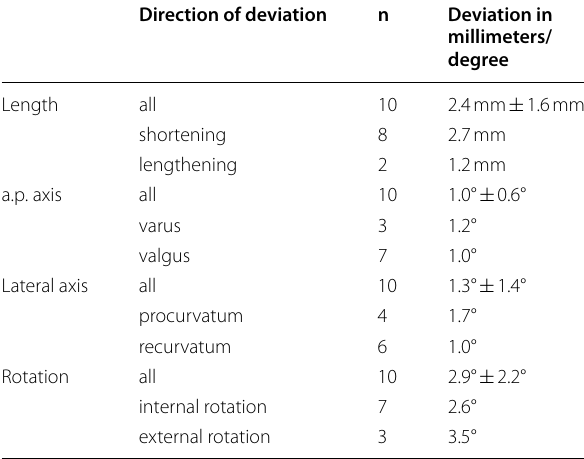
Different overall deviations are given as well as subgroups indicating the direction of malalignment. Column n demonstrates the number of cases. Overall values are given as mean in millimeters and